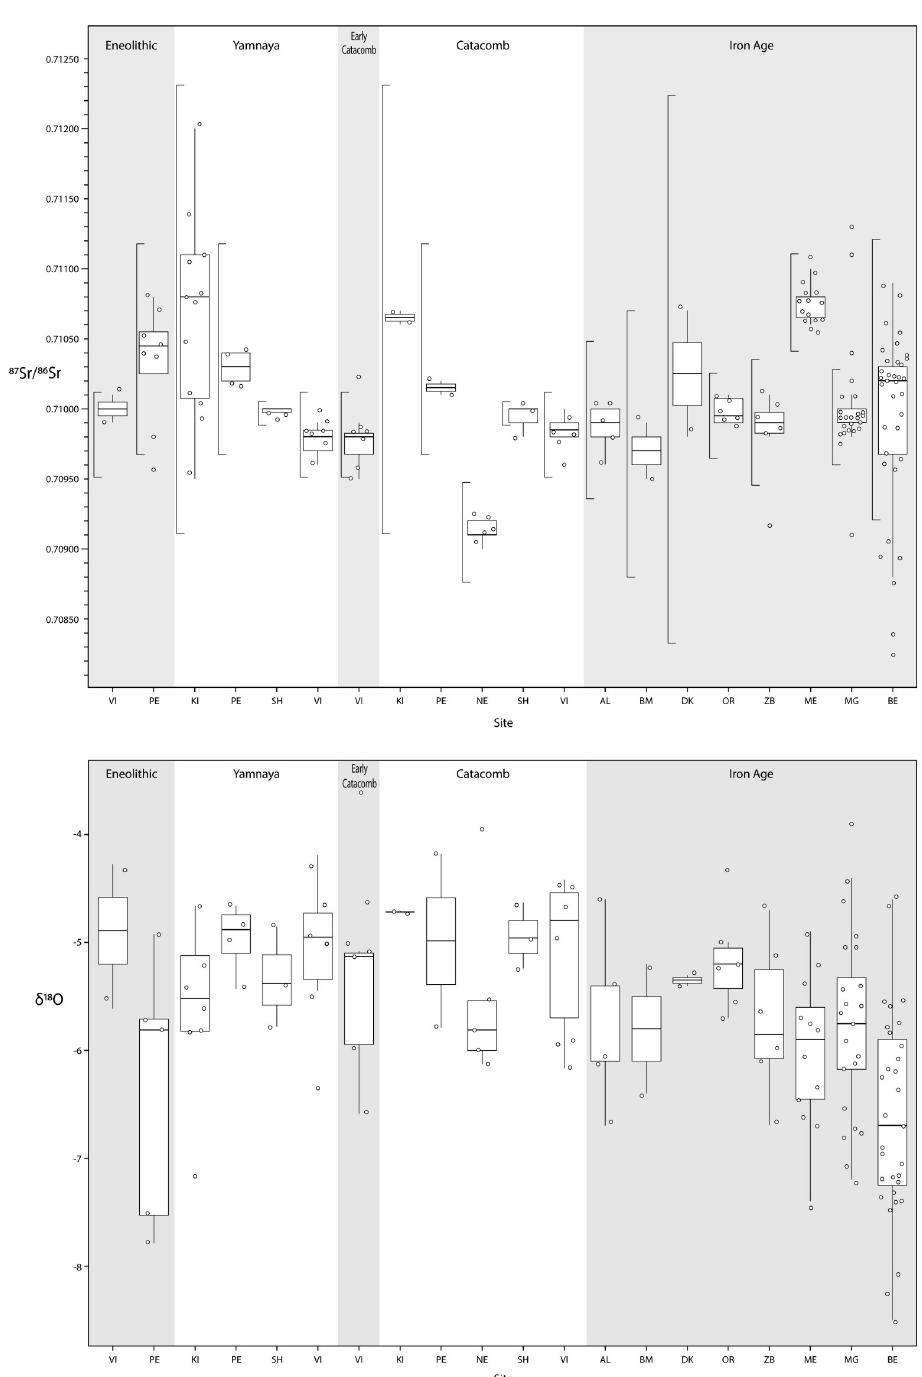
Fig 4. a. Boxplots of strontium isotope ratios for individuals across Ukraine, separated by site and period (bar to the left of each boxplot is the estimated local baseline). b. Boxplots of oxygen isotope ratios for individuals across Ukraine, separated by site and period. Site codes: Vinogradnoe (VI), Peshtchanka (PE), Kirovograd (KI), Shakhta Stepnaya (SH), Nevskoe (NE), Alexandropol (AL), Babina Mogila (BM), Drana Kokhta (DK), Ordzhonikidze (OR), Zolotaya Balka (ZB), Medvin (ME), Mamai-Gora (MG) and Bel’sk (BE).